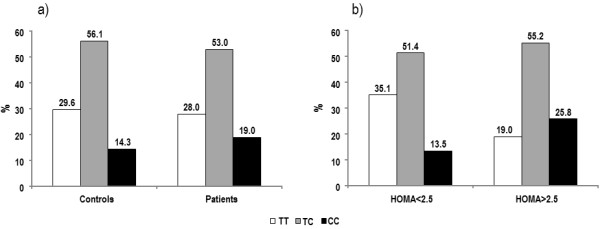
Genotype frequencies for the polymorphism of eNOS gene promoter T−786→C a) in healthy subjects and patients with systolic LV dysfunction and b) in patients with HOMA-IR index<2.5 or with HOMA-IR>2.5.